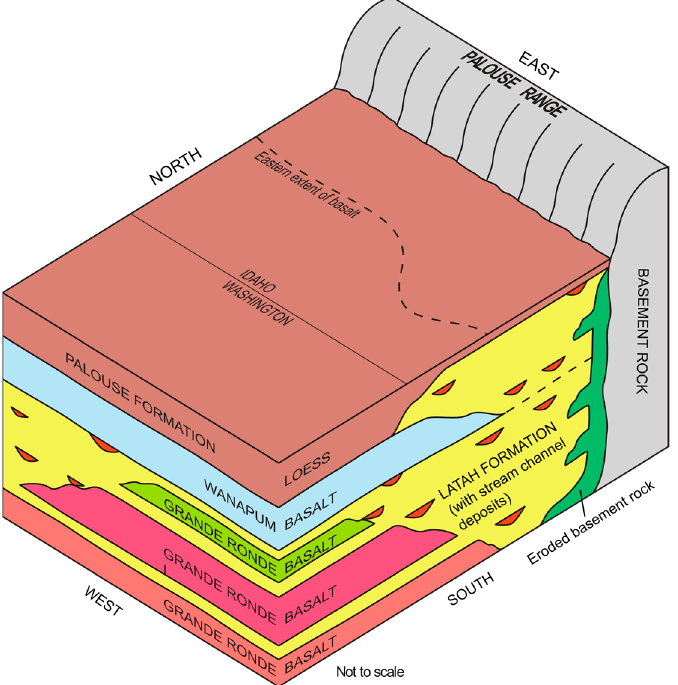
Figure 3. Theorized mountain-front interface of the Palouse Range and sedimentary units of the Latah Formation (modified from Bush et al., 2018 [45]).